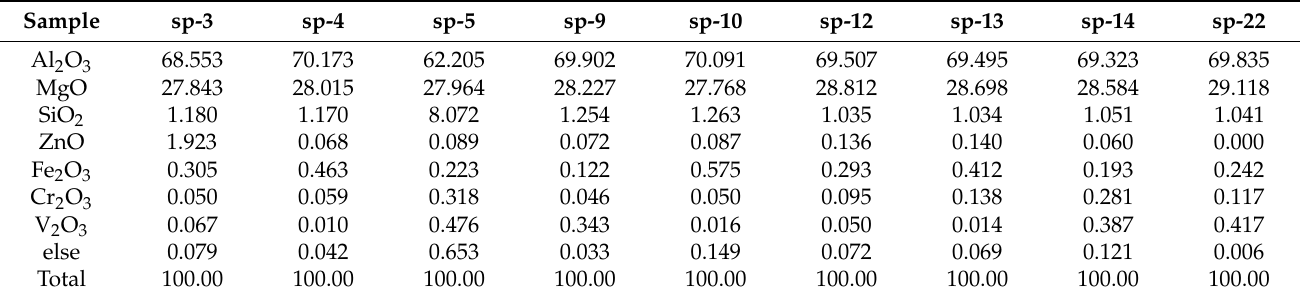
Table 2. ED-XRF chemical composition test results